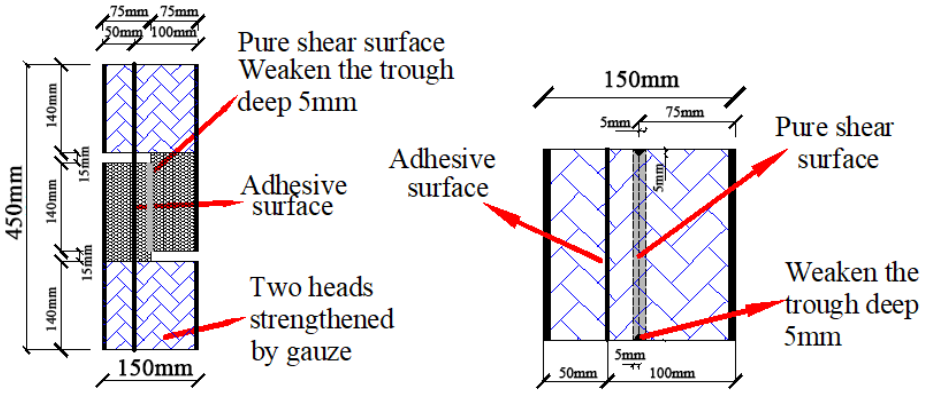
Figure 6. Cross section size of shear test specimen.